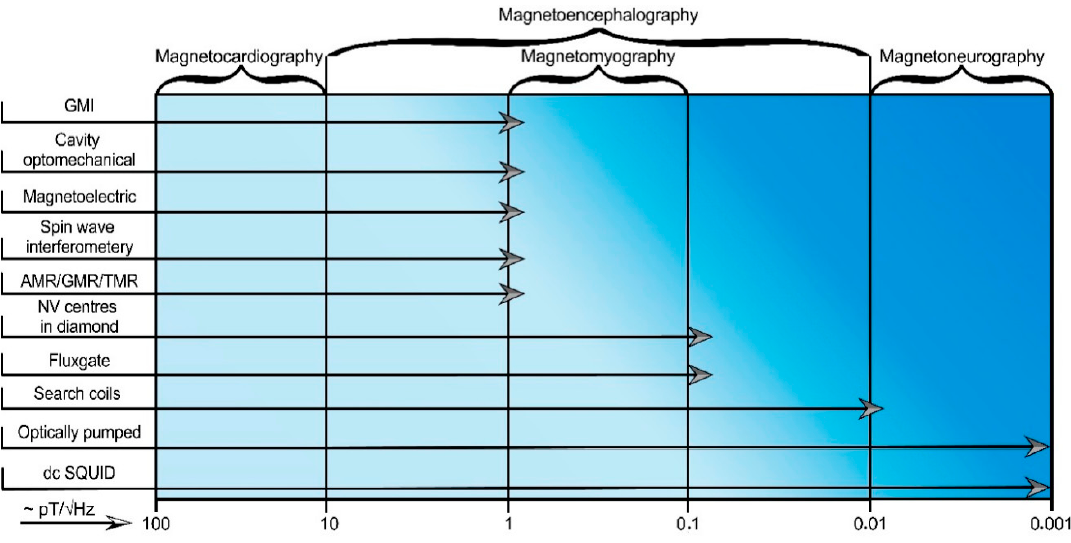
Figure 14. A chart showing how various magnetic sensor technologies ( y -axis) relate to the detection of biomagnetic signals ( x -axis). For precise details of the sensors, refer to the